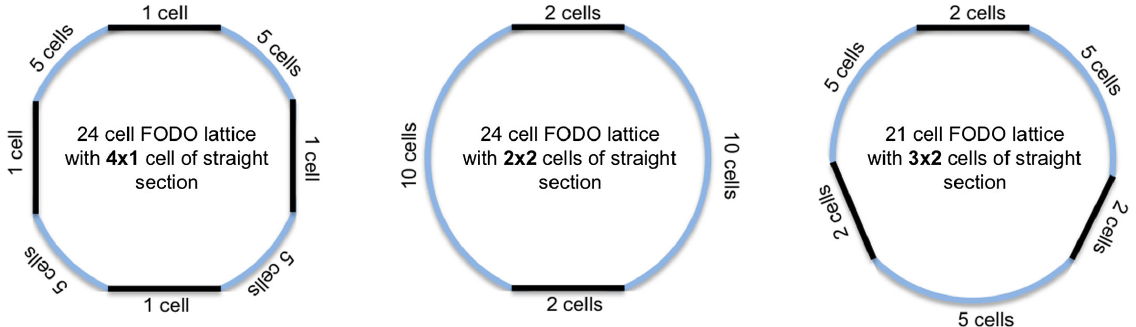
FIG. 19. Sketch of the 24-cell FODO lattice with 4 × 1 cells of straight sections and 2 × 2 cells of straight section, and the 21-cell FODO lattice with 3 × 2 cells of straight